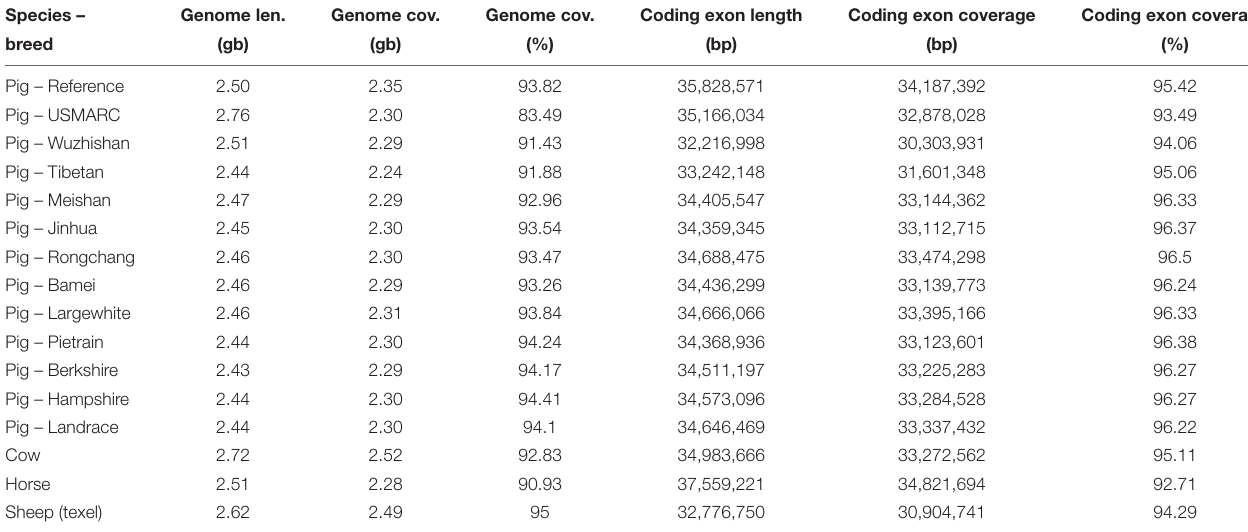
TABLE 3 | Summary statistics of the pig breeds whole genome alignment.